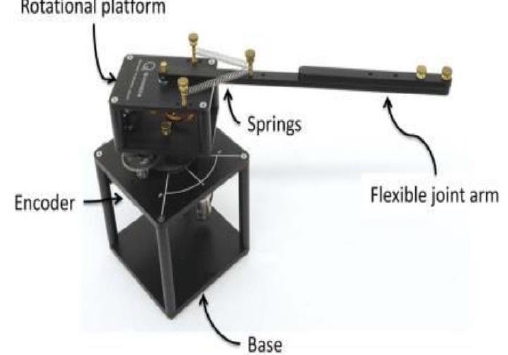
Fig 1. Flexible joint robot arm by Quanser